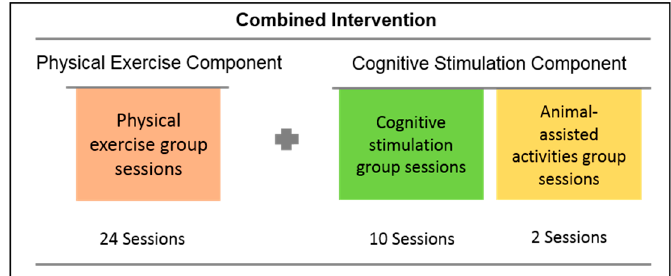
Figure 3. Combined intervention components.